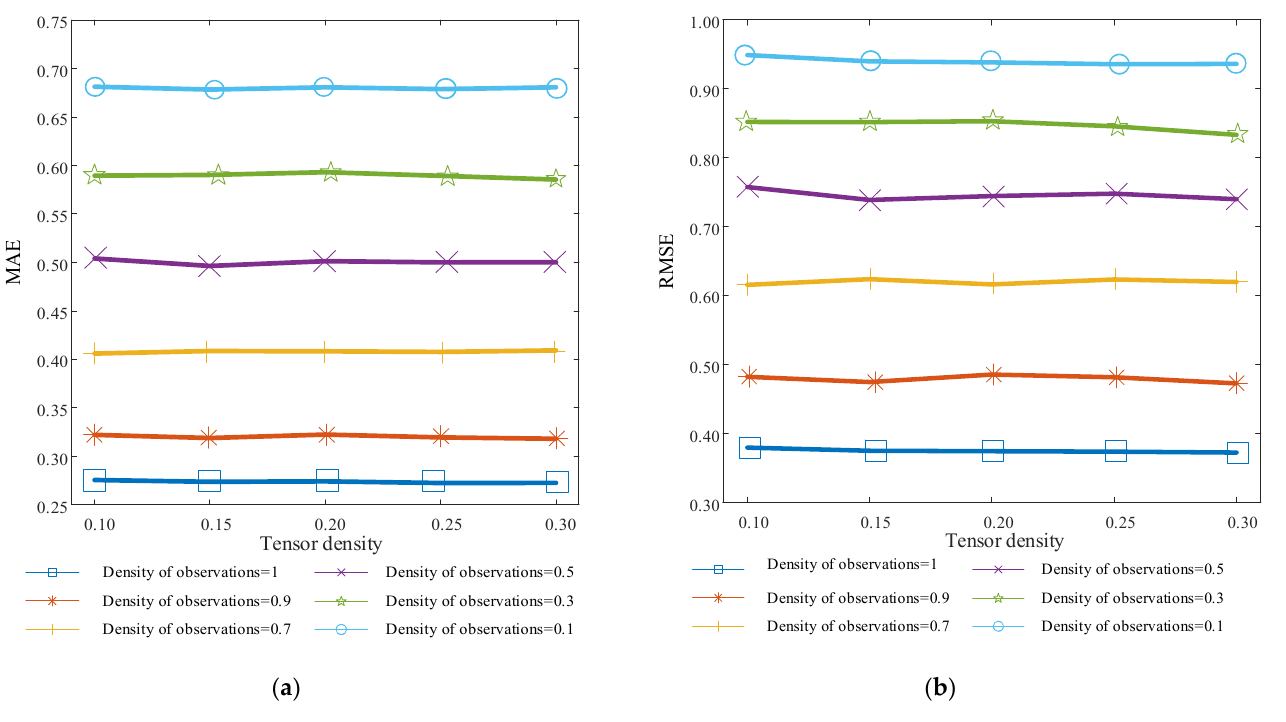
Figure 9. Experimental results on the variation of the sparsity of the observations. ( a ) MAE variation for different tensor densities in the observation variation; ( b ) RMSE variation at different tensor densities in the observation variation.